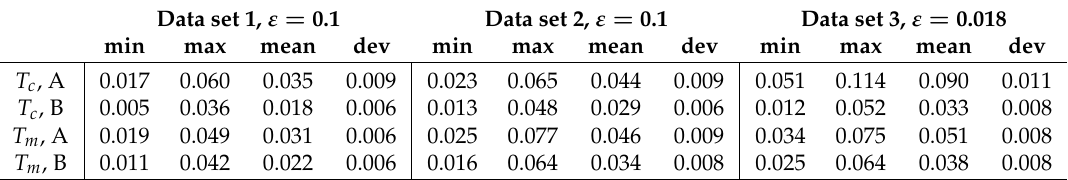
Table 5. Summary of the simulated rejection probabilities at the nominal level 0.05. The rejection probabilities are simulated at the 100 randomly selected boundary points of H 0 . The sample size equals the size of the corresponding data set. The number of replications is 1000 for each experiment. A stands for the asymptotic test and B stands for the bootstrap